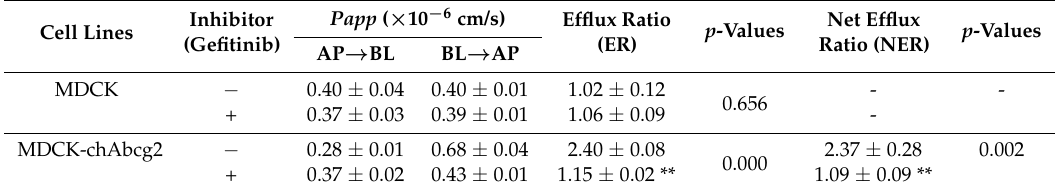
Table 1. Permeability, efflux ratio (ER), and net efflux ratio (NER) of florfenicol (FFC) across different cell